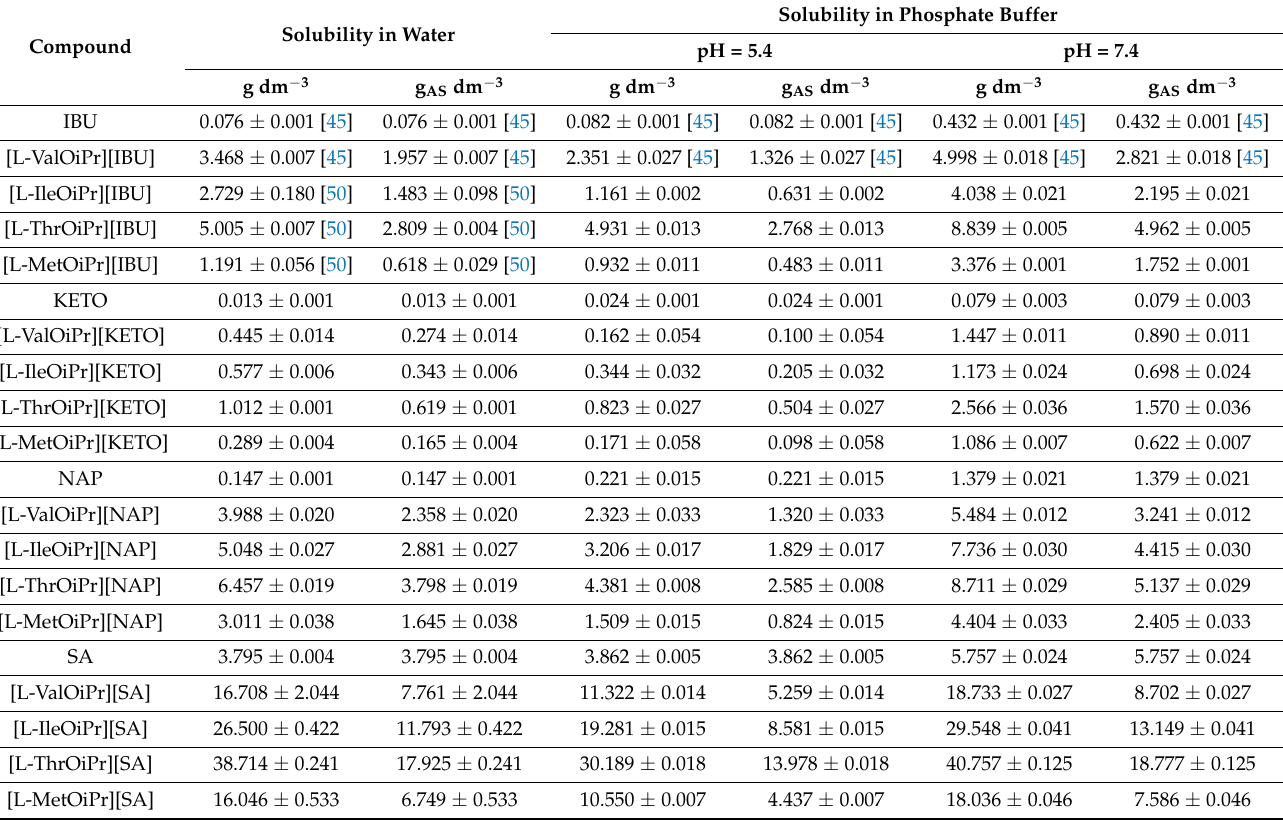
Table 3. Solubility of acids from NSAIDs group and their L-amino acid isopropyl ester salts in water and phosphate buffers at 25 ◦